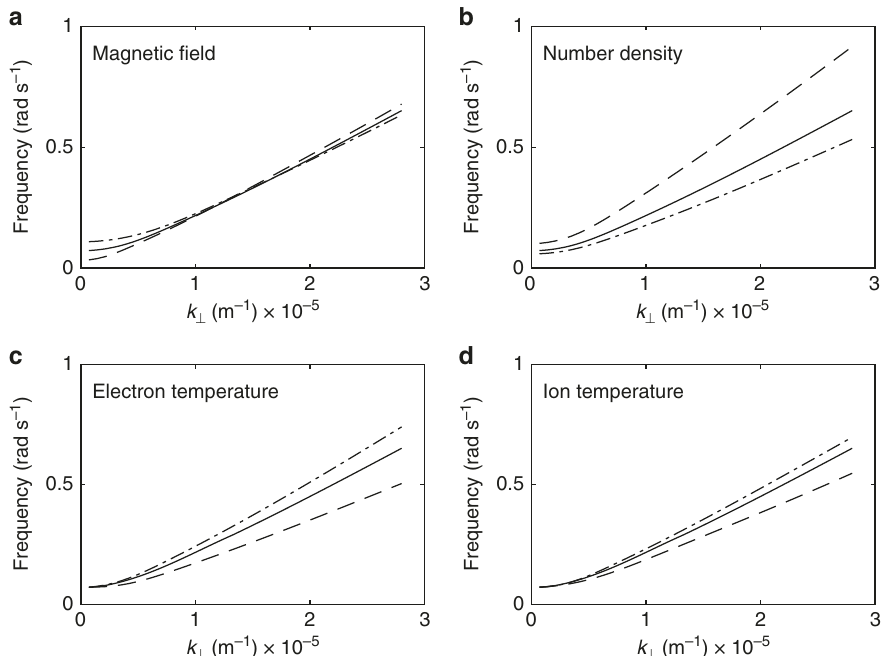
Fig. 10 Solutions of the warm plasma dispersion relation with varying parameters to assess the sensitivity of the solutions. The sensitivity is assessed based on varying each parameter by ± 50%. a k || , n , T e and T i are all kept constant and j B j is varied from 12 nT (dashed line) to 36 nT (dot-dash line). Varying the magnetic fi eld strength does not impact the solution strongly. b k || , B , T e and T i are all kept constant and n is varied from 7.5 × 10 6 m − 3 (dashed line) to 2.25 × 10 7 m − 3 (dot-dash line). c k || , B , n , and T i are kept constant and T e is varied from 1.0 keV (dashed line) to 3.0 keV (dot-dash line). d k || , B , n , and T e are kept constant and T i is varied from 1.5 keV (dashed line) to 4.5 keV (dot-dash